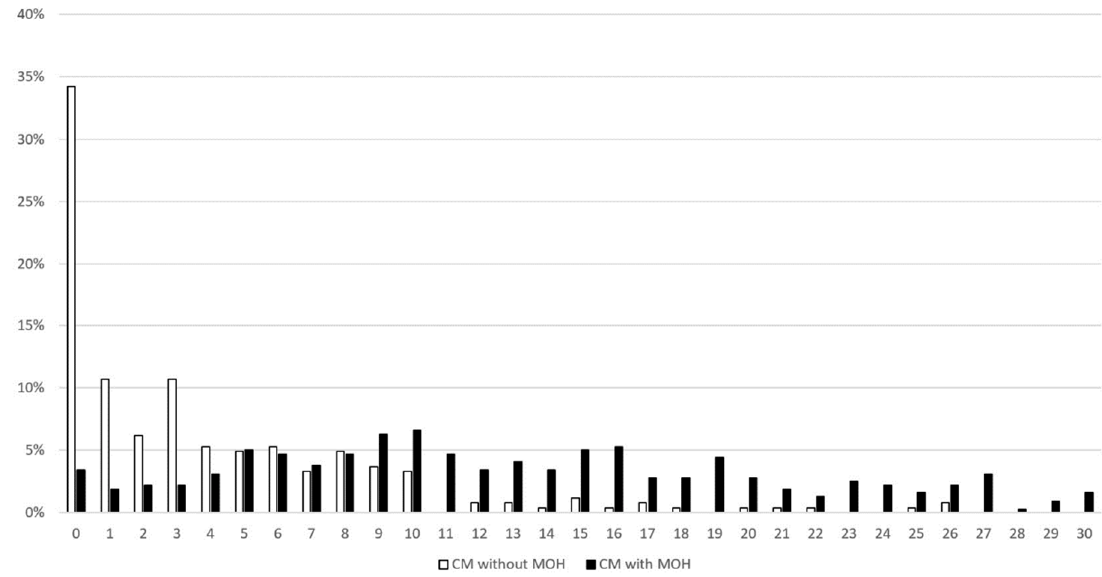
Figure 1. Distribution of LDQ scores in patients with and without MOH. Abbreviations: LDQ = Leeds Dependence Questionnaire, MOH = medication-overuse headache.